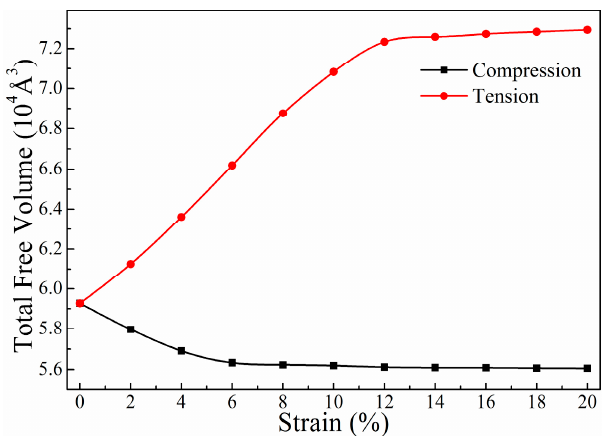
Figure 5. (Color online) Relations between total FVs and strain in tension and compression modes